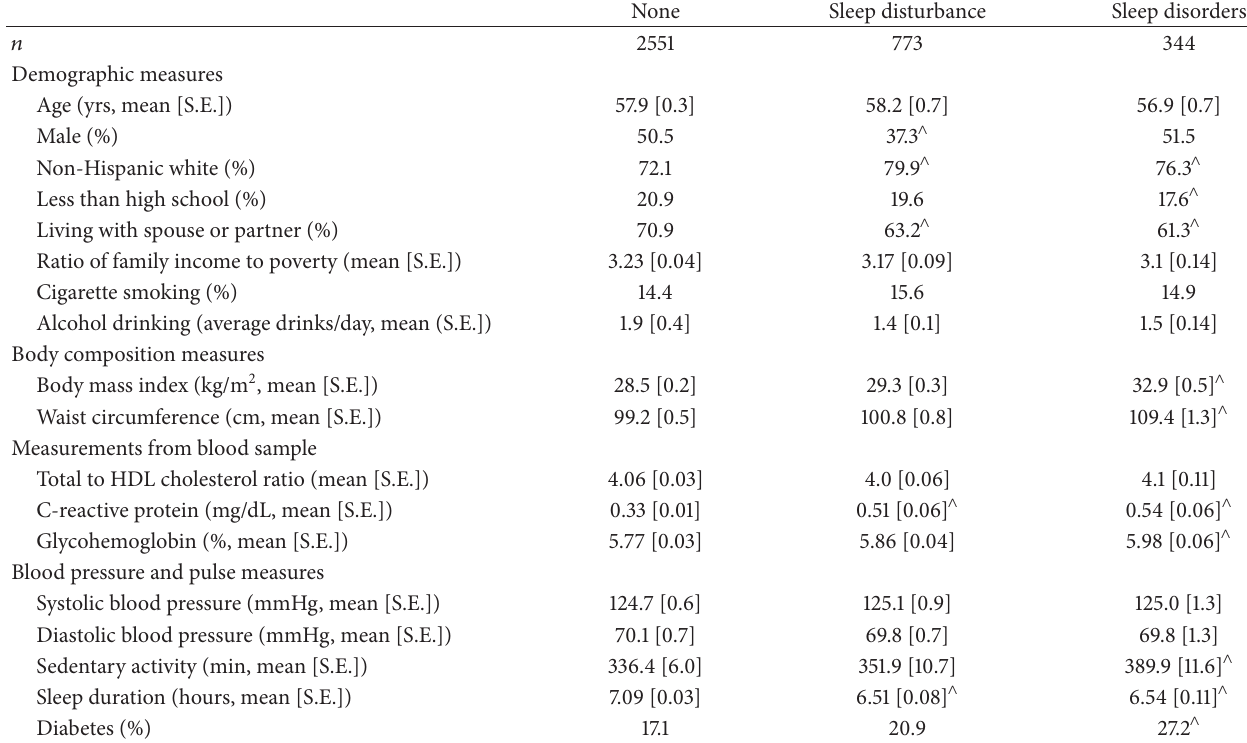
Table 1: Basic characteristics of 3668 participants in the NHANES 2009-2010 by sleep disorder status.